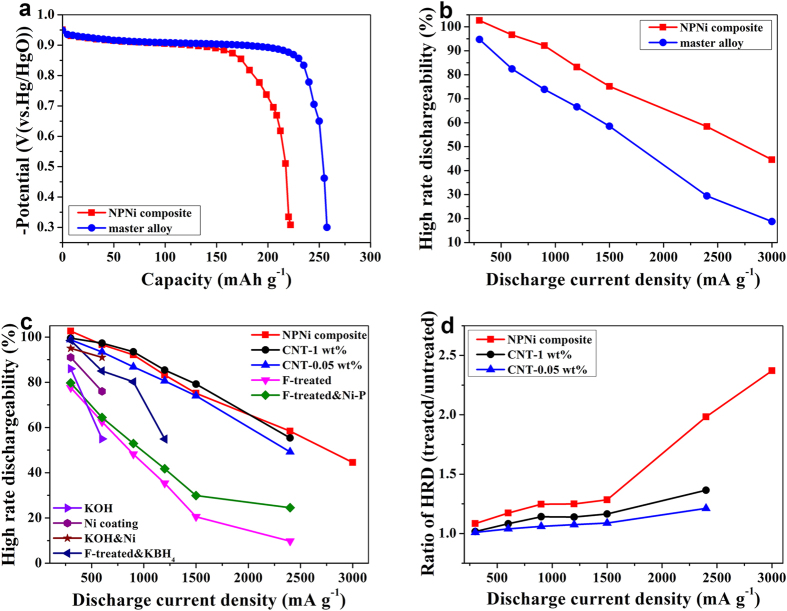
Discharge capacities and HRD properties.(a) The discharge capacity curves of the HSAs/NPNi hybrid electrode and master alloy electrode at room temperature. (b) The HRD properties of the HSAs/NPNi hybrid electrode and master alloy electrode at different discharge current densities measured at room temperature. (c) Comparisons of HRD properties of the HSAs/NPNi composite and reported experimental data of AB5-type HSAs from other advanced surface modification methods, including carbon nanotube (CNT) doping (CNT-1 wt% and CNT-0.05 wt%) for MmNi3.6Co0.7Al0.3Mn0.427, fluoridation treatment (F-treated), fluoridation and the following treatment with KBH4 (F-treated & KBH4) for MlNi3.8Co0.75Mn0.4Al0.215, combination of fluoridation treatment and elelctroless plating with Ni-P coating (F-treated & Ni-P) for LaNi4Al25, hot alkaline treatment at 100 °C (KOH), electroless with nickel coating (Ni coating), and combination of alkaline treatment and electroless with Ni coating (KOH & Ni) for MmX4.3(Al0.3Mn0.4)0.5 (X = Co, Mo, Mn, Al, Cu)14. (d) A comparison of ratios of HRD performance after treatment to that of untreated HSAs between NPNi incorporation and CNT doping.